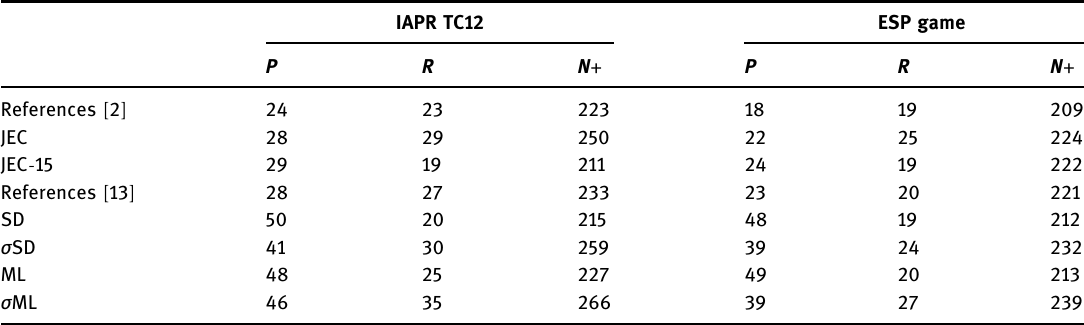
Table 3: Two variants of the proposed algorithm model ( K = 200 ) comparison with other algorithm models in terms of the performance of P, R , and N